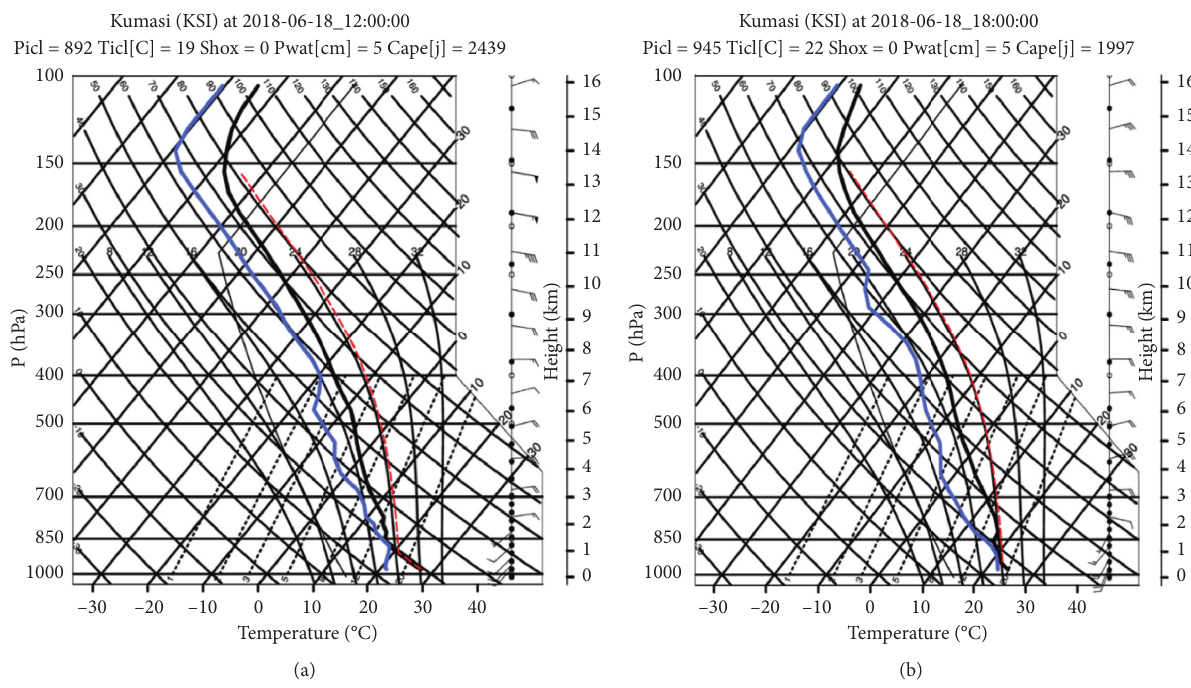
Figure 15: WRF skew-T diagram showing atmospheric dynamics for case B (a) at 12 UTC and (b) at 18